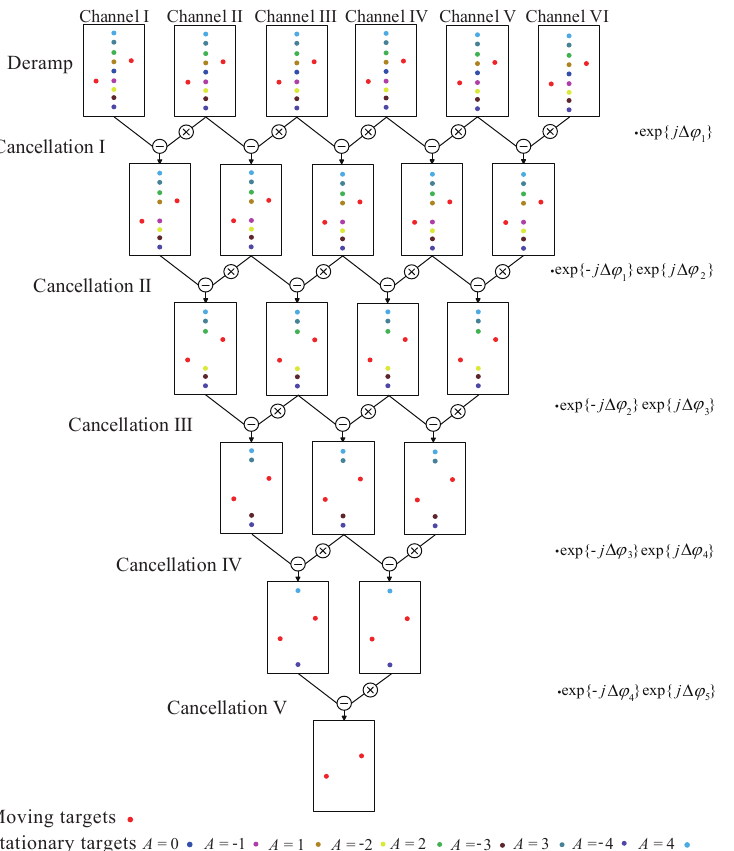
Figure 6. According to Equation (21), signal usage strategy that we designed for the multilayer channel-cancellation in this paper for fast implementation with nine stationary targets and two moving targets in an HRWS SAR